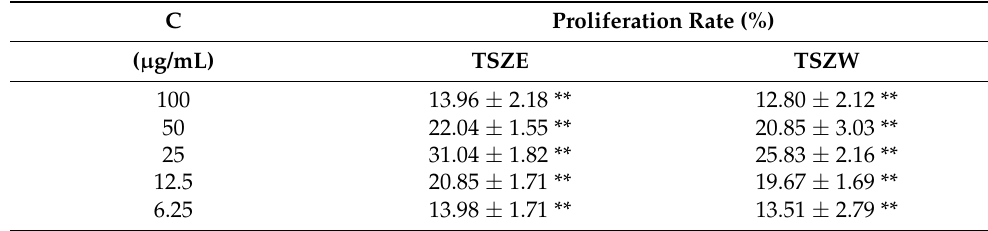
Table 7. Proliferation activity of TSZE and TSZW on NSCs.